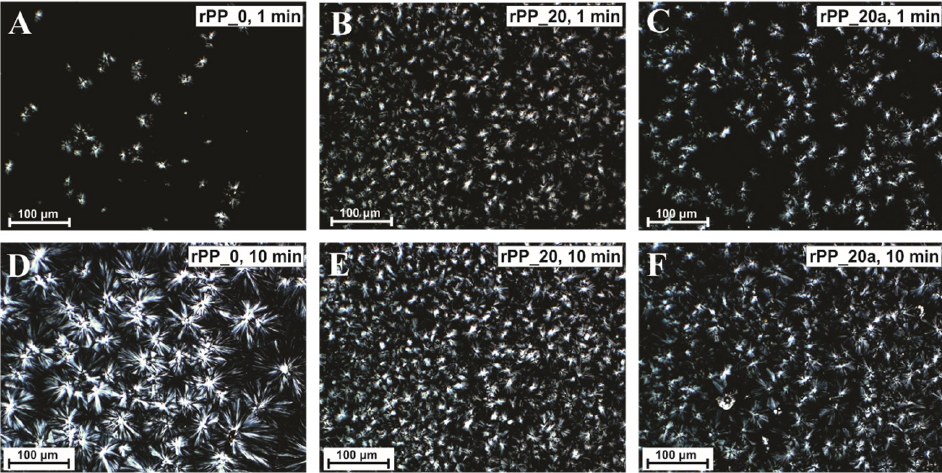
Figure 2. Polarizing optical microscopy of the nucleation and growth processes of virgin PP—rPP_0 ( A , D ), rPP_20 ( B , E ), and rPP_20a ( C , F ) after isothermal crystallization at 130 °C for 1 min ( A – C ) and 10 min ( D – F ).